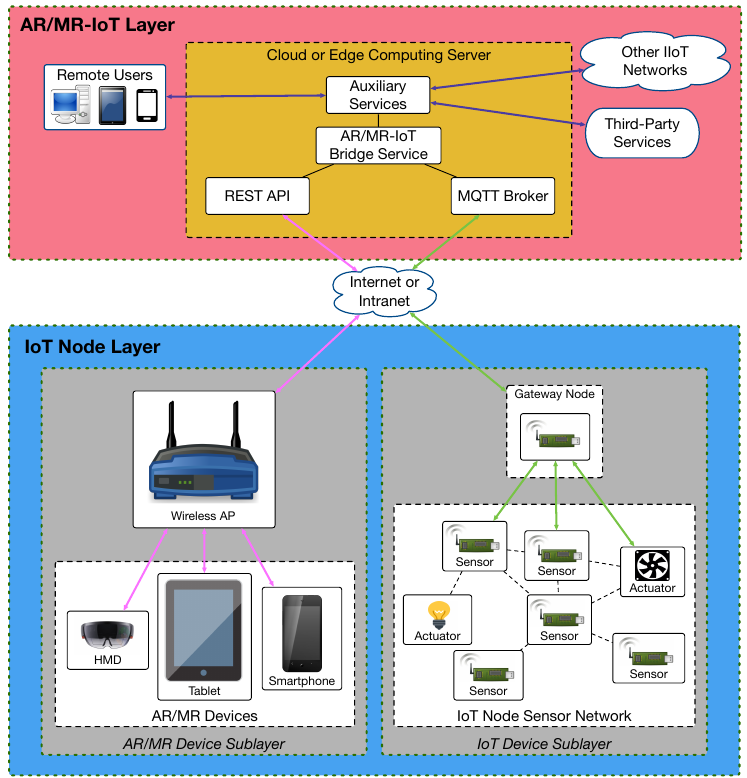
Figure 1. Communications architecture of the proposed